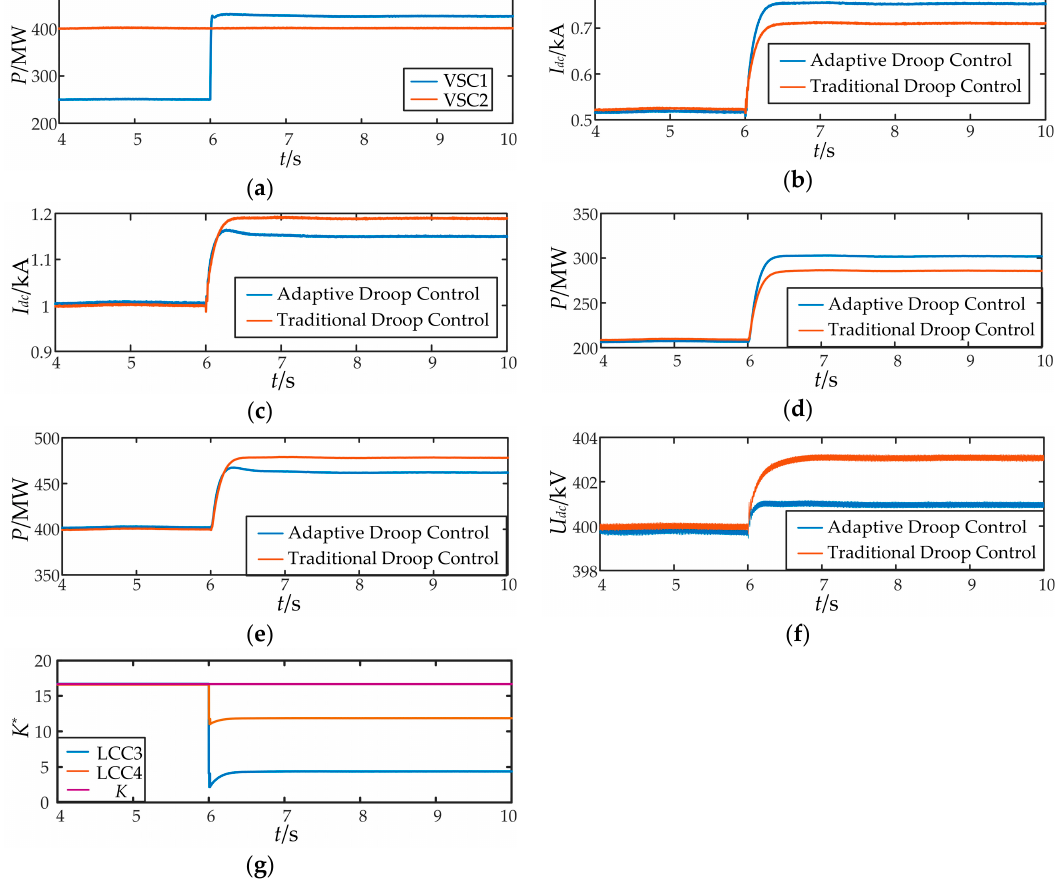
Figure 13. Simulation waveforms of an increase of active power: ( a ) Active power of VSC1 and VSC2; ( b ) DC current of LCC3; ( c ) DC current of LCC4; ( d ) active power of LCC3; ( e ) active power of LCC4; ( f ) DC voltage; ( g ) adaptive droop coefficient of LCC converter stations .